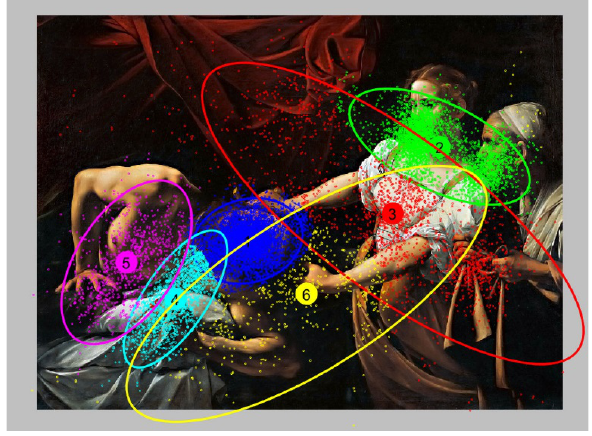
Figure 3. The dependence of the BIC value on number of clusters for the P2 image.